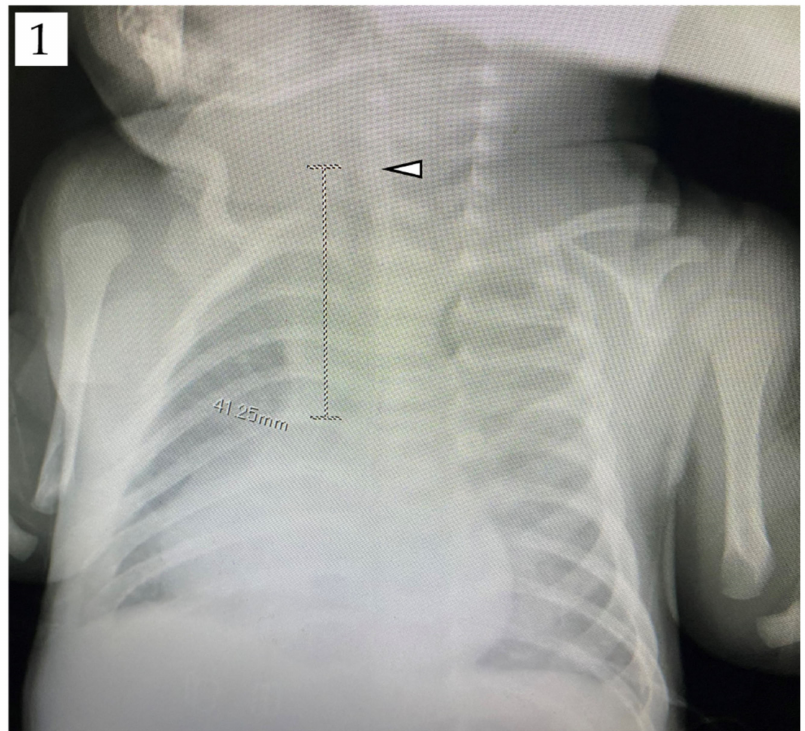
Figure 1. Measurement of tracheal length on chest radiographs by using the picture archiving communication system. The distance between the vocal cords ( (cid:52) ) and carina tracheae was defined as the tracheal length. This sample patient was 7 days old, 51 cm tall, and weighed 3.1 kg, undergoing arterial switch surgery for transposition of the great arteries. The tracheal length was measured as 41.3 cm, which corresponded to 8.1% of the body